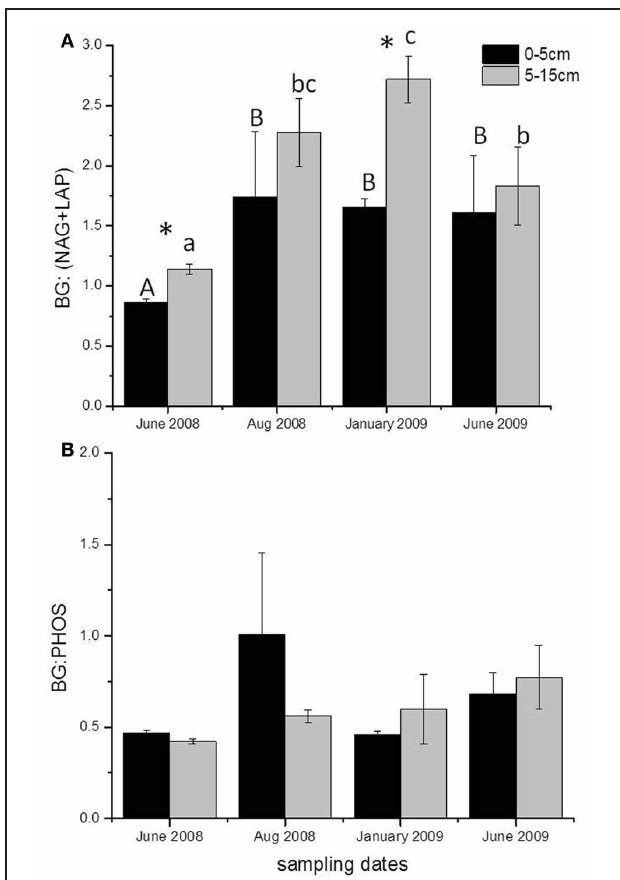
FIGURE 4 | Stoichiometric ratios of potential enzyme activity at different sampling dates for both depths, (A) BG: (NAG + LAP) at 0–5 and 5–15cm depths and (B) BG: PHOS at 0–5 and 5–15cm depths below the soil surface. Different capital letters and lower case letters, for 0–5cm and 5–15cm depths respectively, indicate significant differences between sampling dates, and an asterisk indicates a significant difference by depth ( P < 0 . 05). Averages and standard errors were calculated using all the plots for each date due to the lack of treatment effect on enzyme stoichiometry; n =